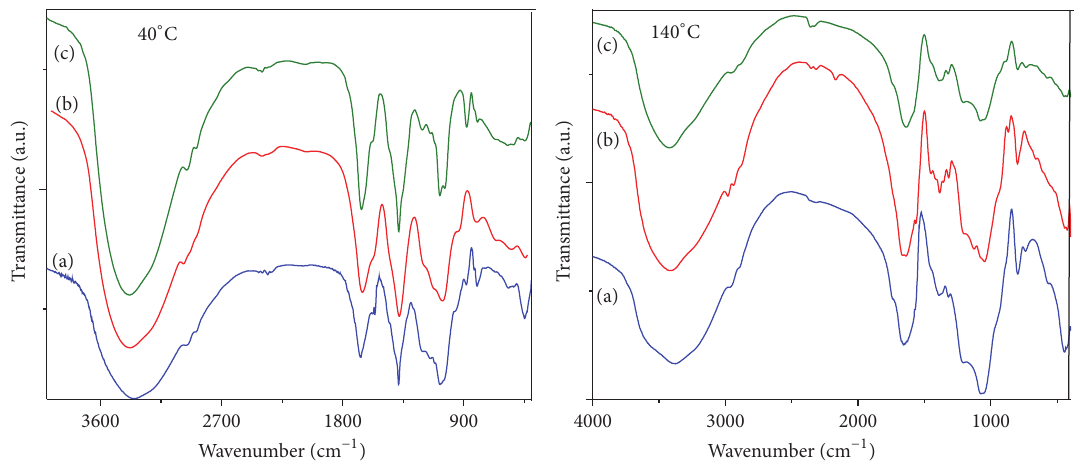
Figure 1: FT-IR spectra of the gels obtained using 1,2-ED (a), 1,3-PD (b), and 1,4-BD (c) dried at 40 ∘ C and 140 ∘ C.